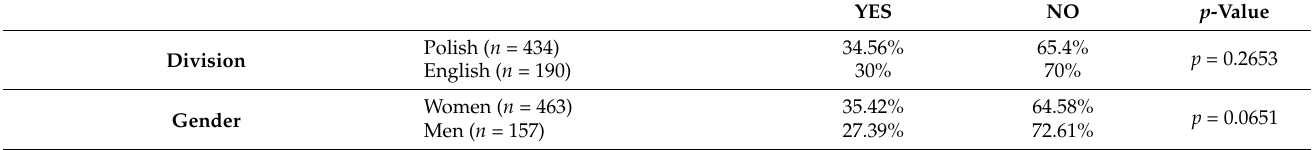
Table 2. The use of dietary supplements for stress, anxiety, depression, or sleeping problems among Wroclaw Medical University Students in the academic year 2020/2021. Analyses were performed using the chi-square